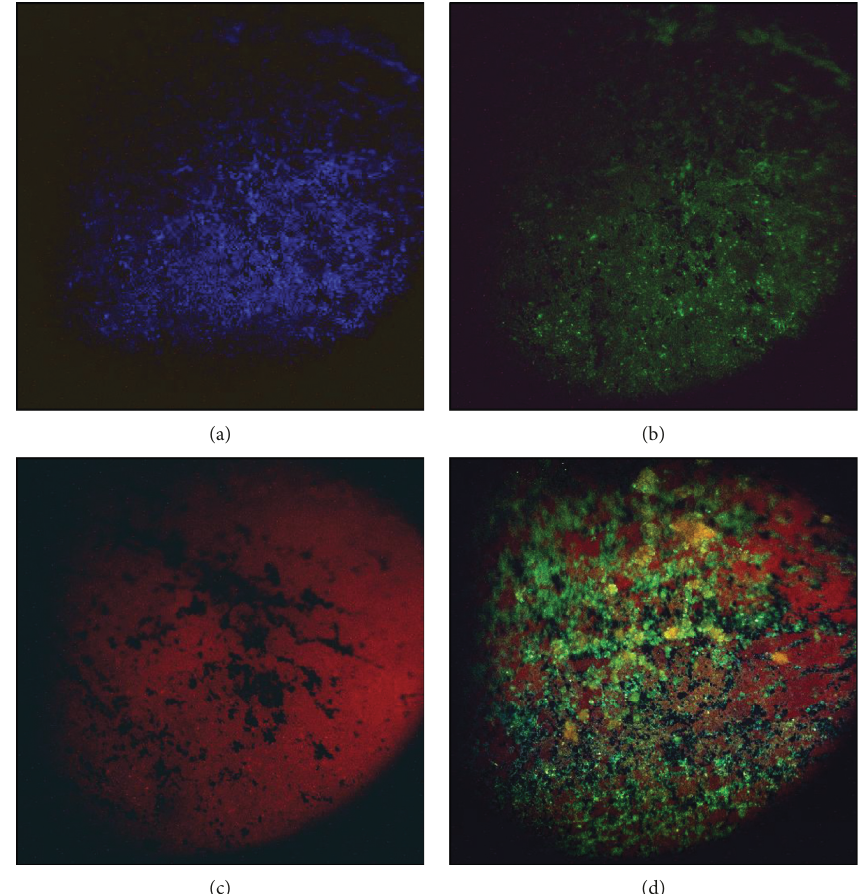
Figure 9: Multiferroic LiNbO 3 SHG properties: (a) blue color, (b) green color, (c) red color, and (d) overlap between green and red, showing yellow